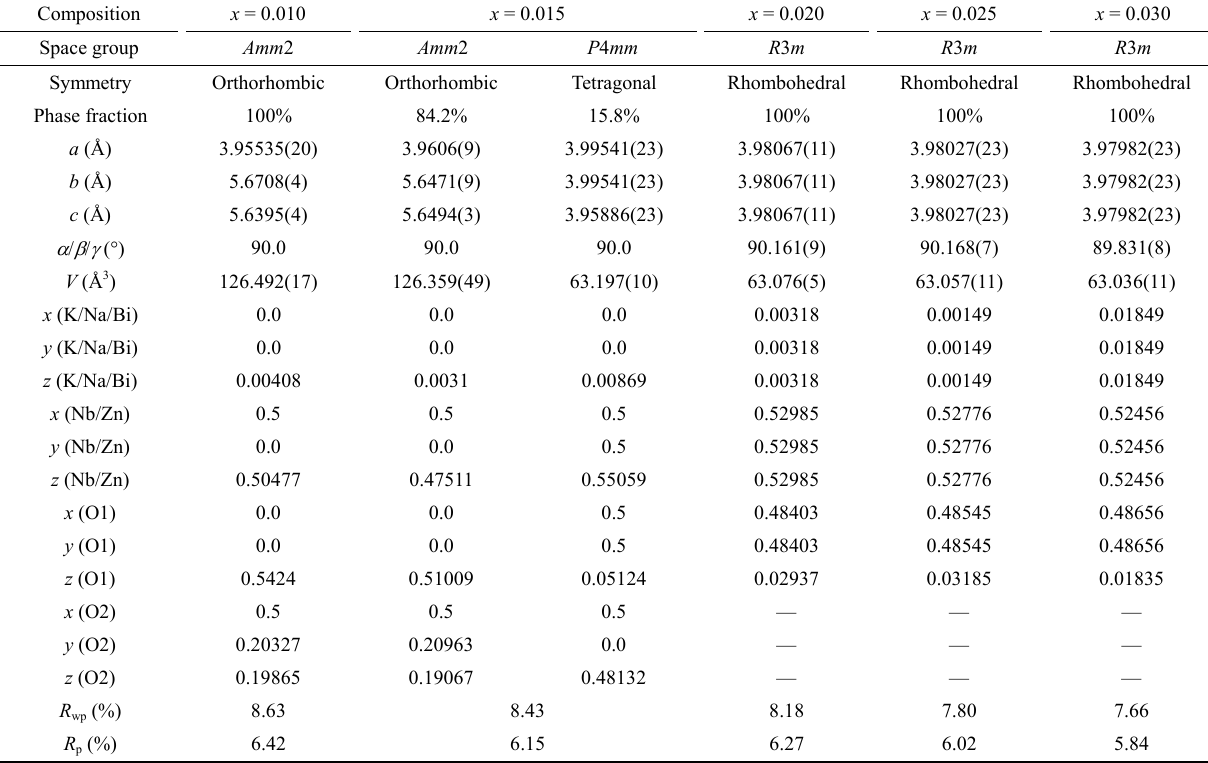
Table 1 Detailed crystalline parameters, R wp , and R p factors of Rietveld refinement for (1 − x )KNN– x BZN ( x = 0.010, 0.015, 0.020, 0.025, and 0.030) ceramics at RT